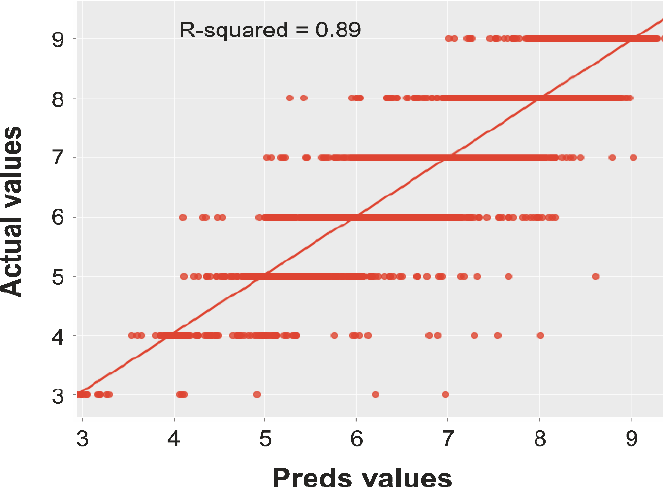
Figure 3. Test coefficient of the determination analysis for the superstructure condition model.